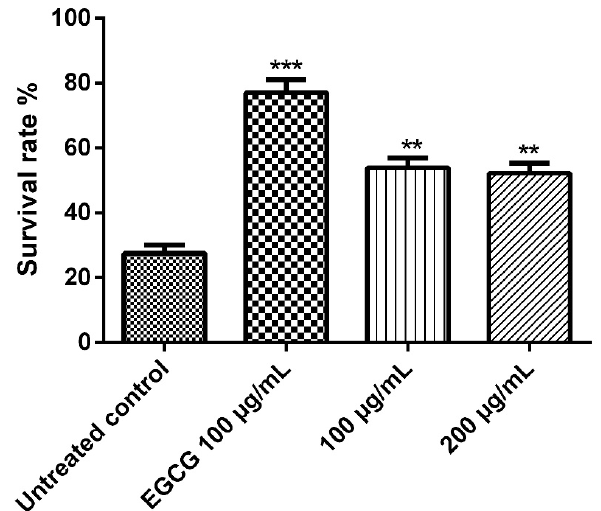
Figure 5. Survival rate of the worms under juglone (80 µM) treatment. Treatment of the worms with 100 and 200 µg/mL of E. divinorum extract on N2 nematodes. E. divinorum extract improved their resistance to oxidative stress and increased the survival rate to 56.29% and 50.00%, respectively, the positive control, EGCG (100 µg/mL), increased the survival rate to 76.00%. The survival rate of the juglone treatment alone was 26.32%. Significant differences relate to the control group at ** p < 0.01 and *** p < 0.001 by one-way ANOVA and Tukey’s post hoc